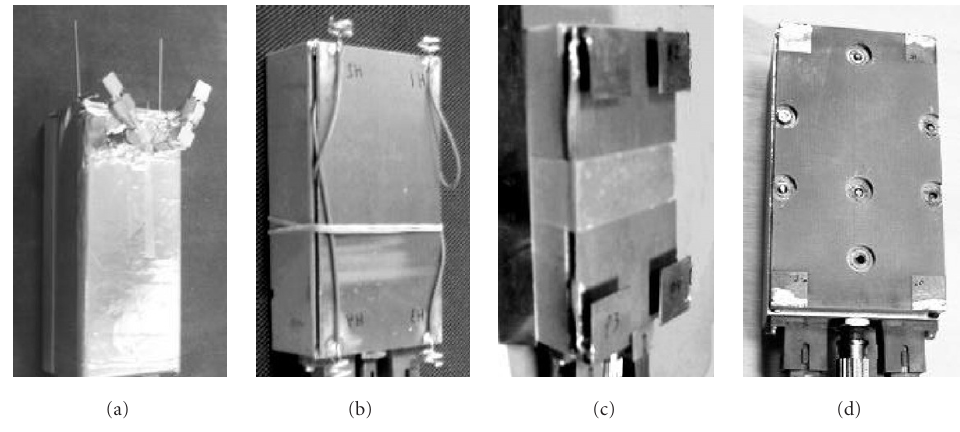
Figure 5: Antenna placements on handsets: (a) first handset with monopoles for indoor; (b and c) second handset with helices and PIFAs for outdoor-to-indoor; and (d) second handset with dielectric PIFAs for outdoor. All handsets are shown without radome or protective cover.